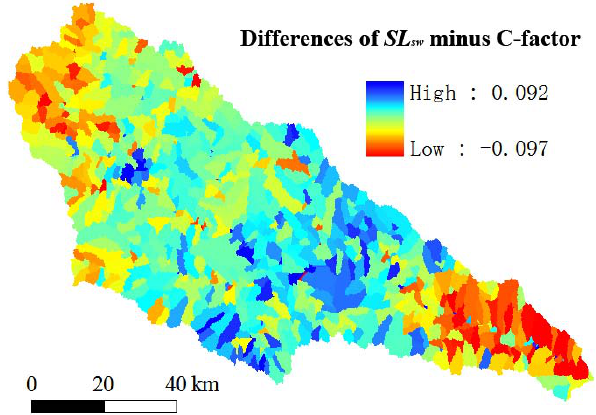
Fig. 9. Spatial distribution of the differences (SL sw minus C-factor) for the sub-watersheds in the Yanhe